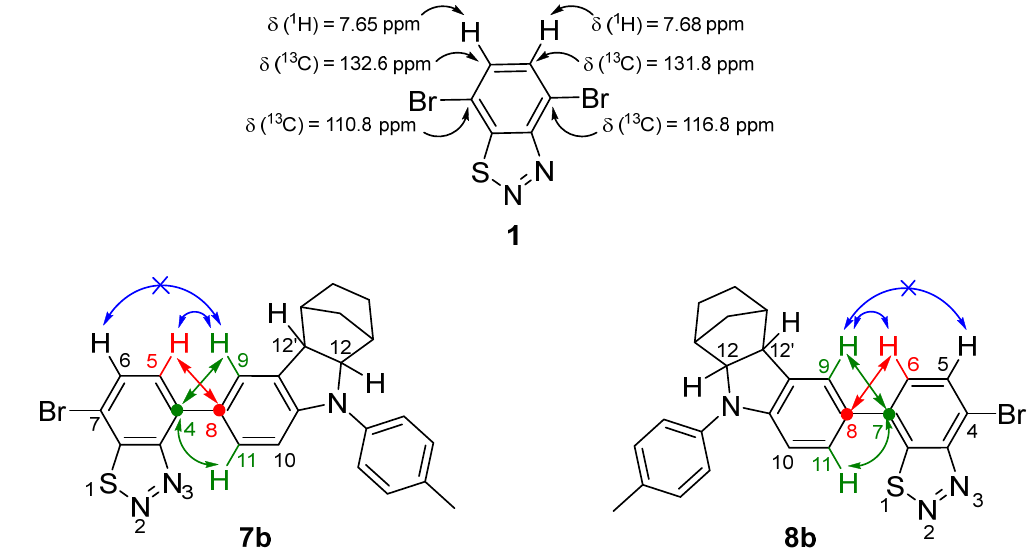
Figure 1. Basic chemical shifts in the spectra of 1 H and 13 C of 4,7-dibromobenzo[ d ][1,2,3]thiadiazole and key interatomic interactions allowing signal assignments in monobromo isomers 7b and 8b .